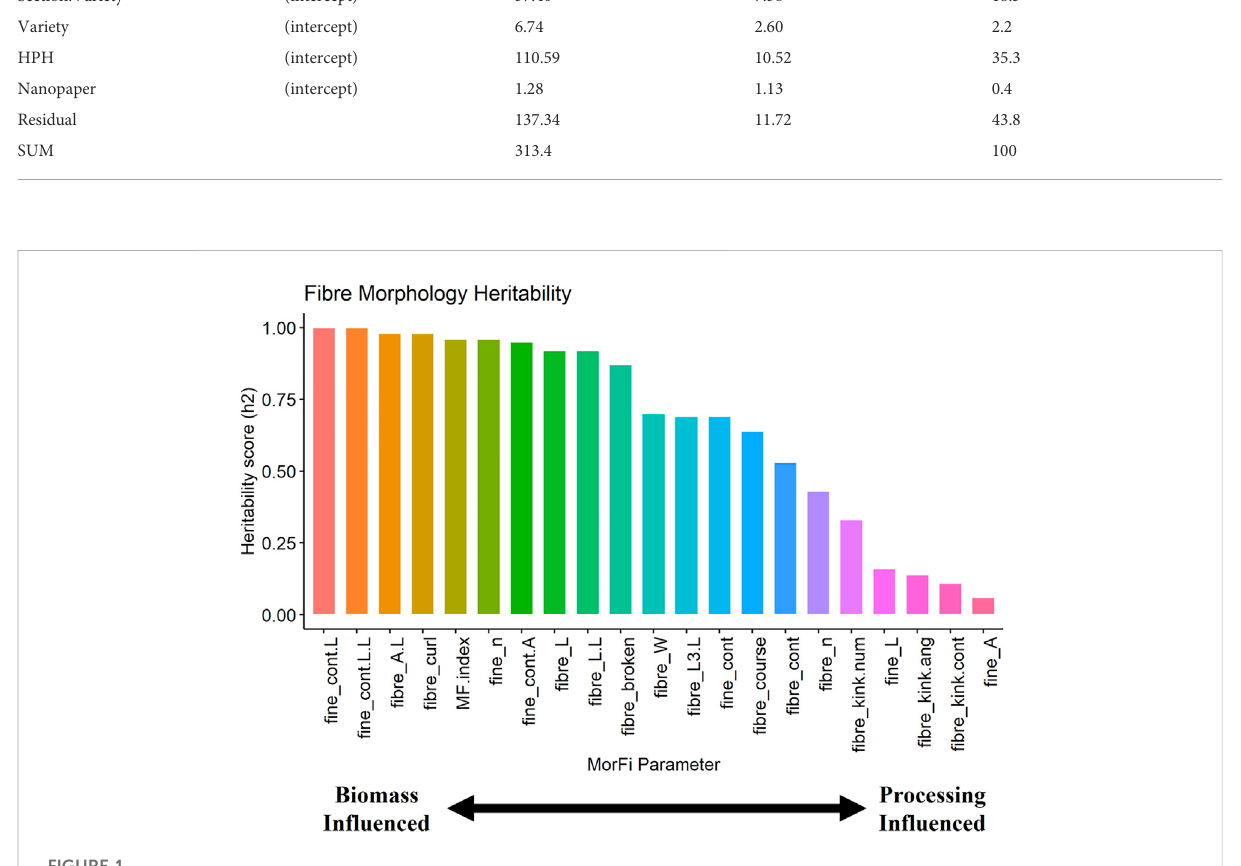
FIGURE 1 Ranking of heritability scores for each fi bre morphology